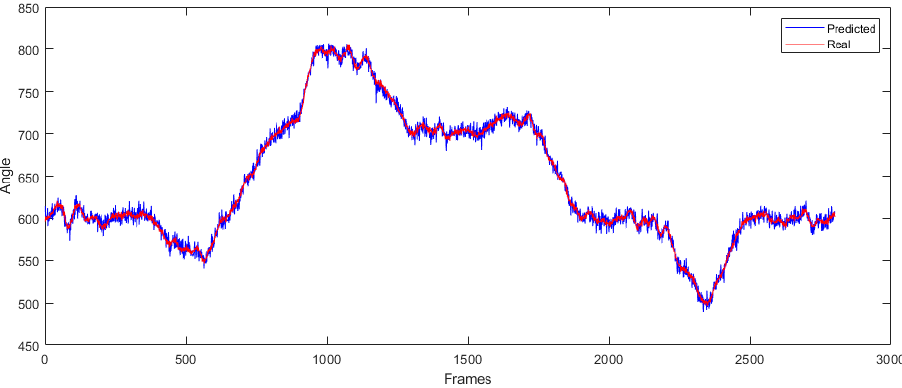
Figure 15. Prediction of the steering angle in a sample dataset.